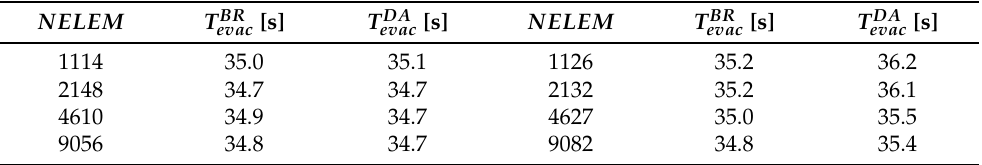
Table 1. Domain with one obstacle, FV (Splitting Scheme I-left) and FV-DG (Splitting Scheme II- right)-Comparison of computations on series of meshes, NELEM = # T h , T BR evac = evacuation time with Bornemann-Rasch algorithm for the determination of φ in (8), T DA evac = evacuation time with Dijkstra’s algorithm for the determination of φ in